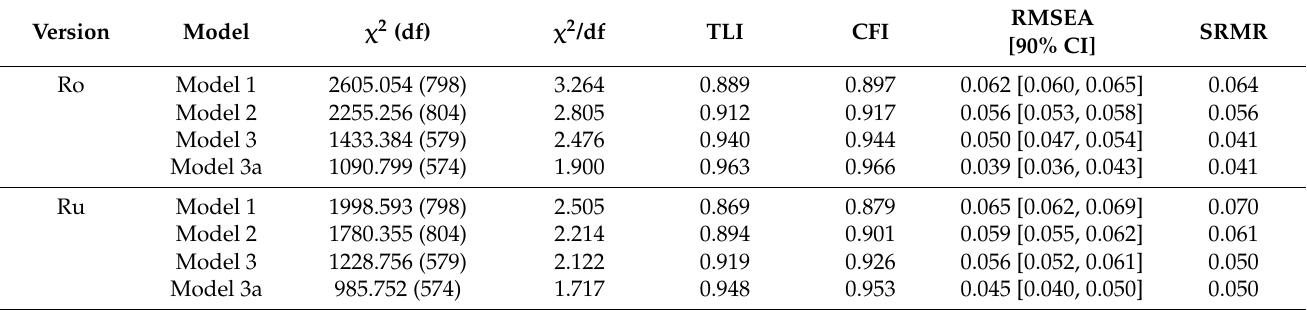
Table 2. Goodness of fit indicators of the models of the SSMMQ using confirmatory factor